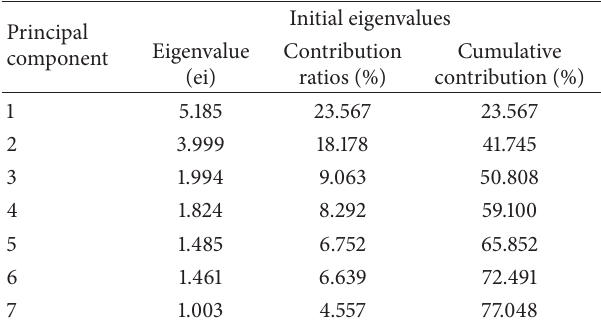
Table 3: The results of principal component analysis